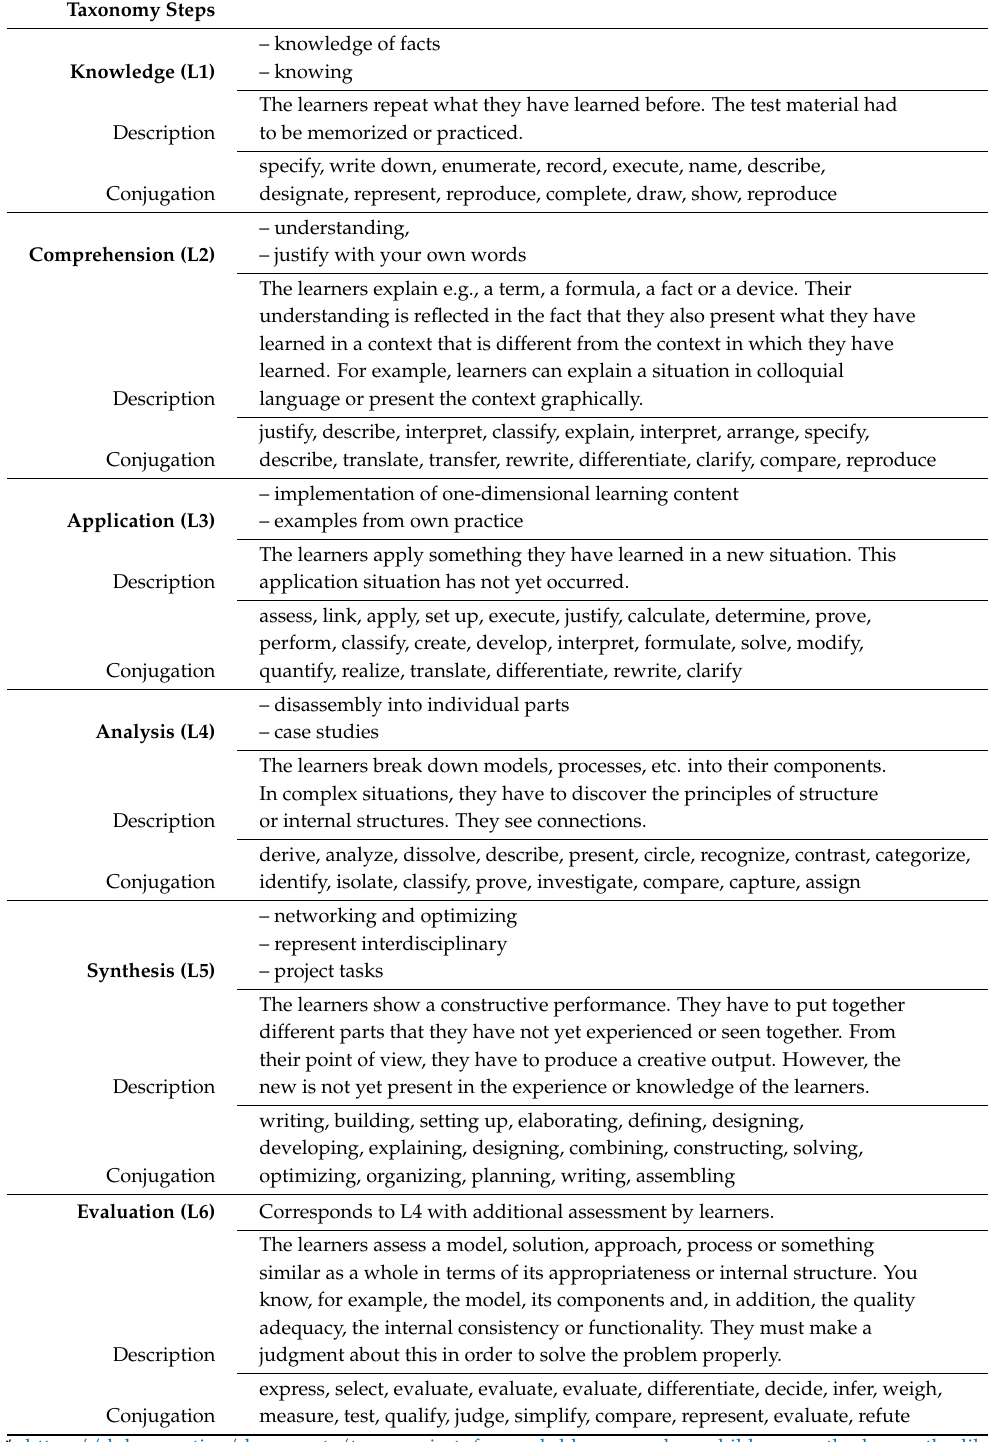
Table 5. Original taxonomy steps after Bloom with six levels (L1–6), including their descriptions and conjugations to be applied